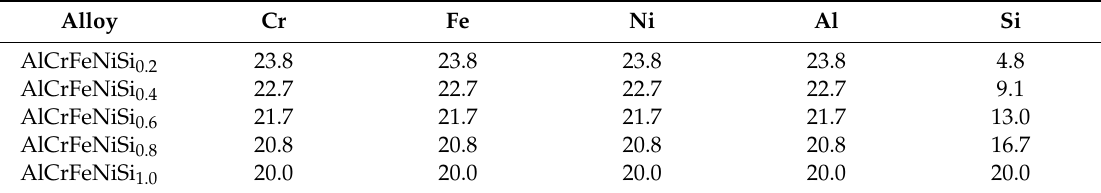
Table 1. Design of AlCrFeNiSi x high-entropy alloy (mole ratio /